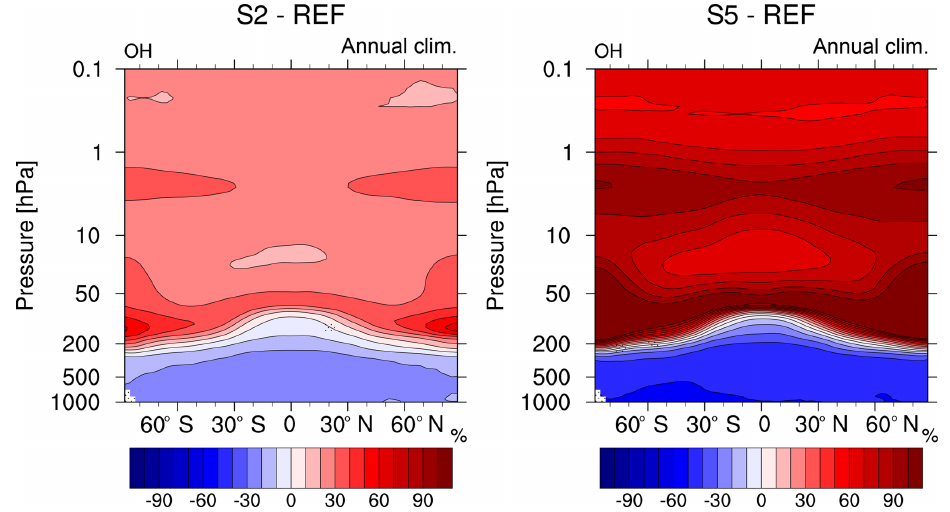
Figure 4. Comparison of the relative changes (%) in annual zonal mean OH mixing ratio of the sensitivity simulations S2 and S5 (2- and 5-fold CH 4 ) compared to the reference REF. Non-stippled areas are significant on a 95% confidence level according to a two-sided Welch’s